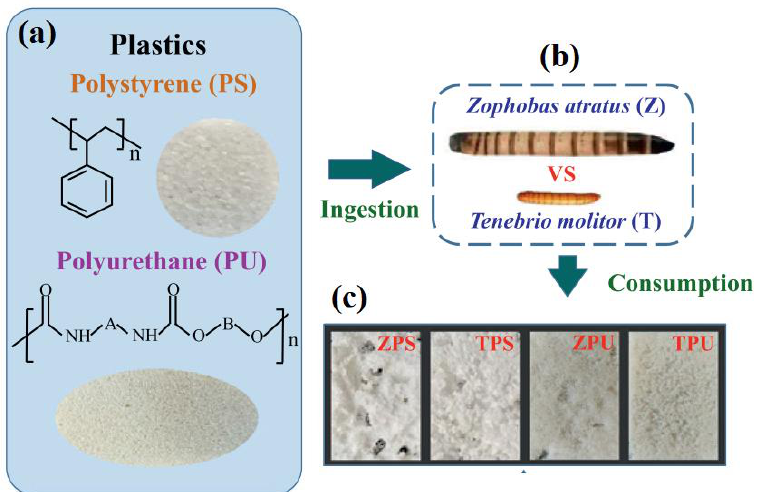
Figure 3. ( a ) PS and PU used in the study. ( b ) Hollows and pits on PS ( c ) Zophobas atratus and Tenebrio molitor used in the stud, adapted from